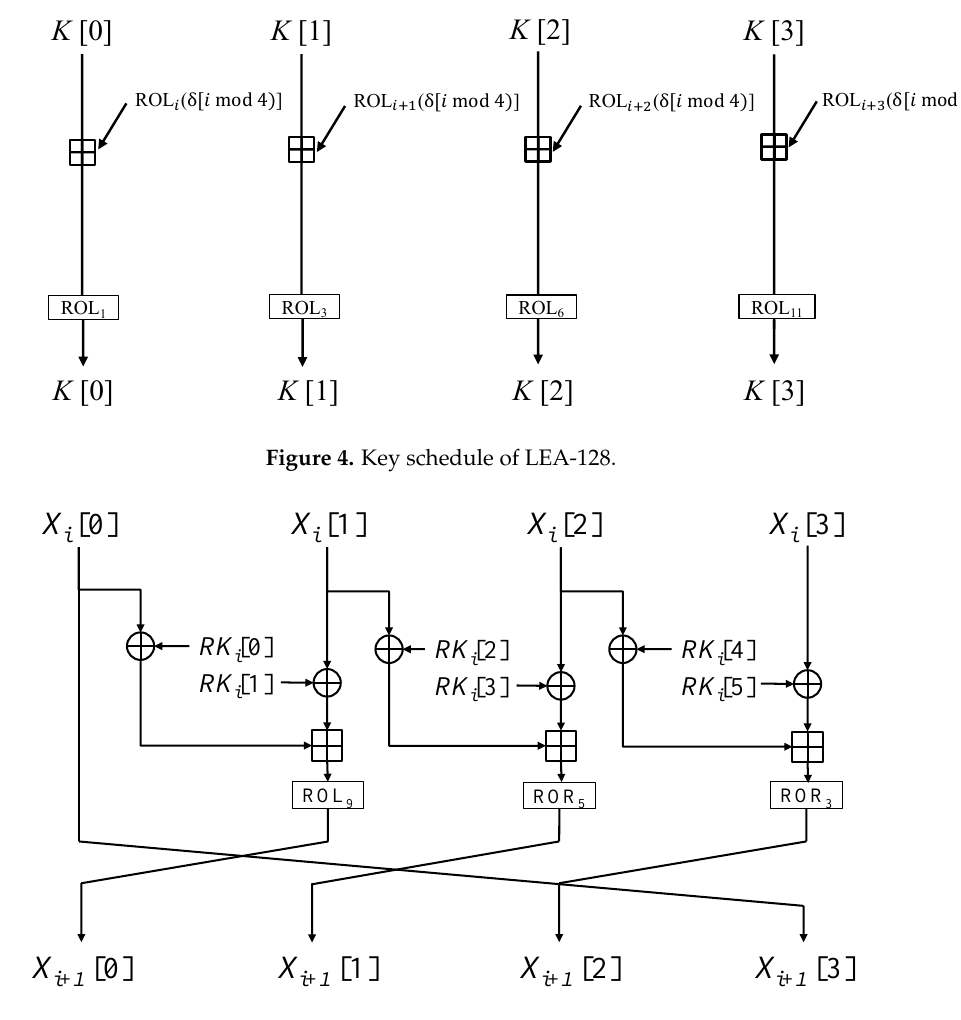
Figure 5. i -th round function of LEA.